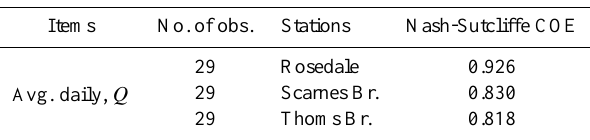
Fig. 18. Water discharge at Rosedale with basin avg. rainfall (ML=Mega liters). Table 7. Performance evaluation of hydrological modeling at La- trobe River Basin.